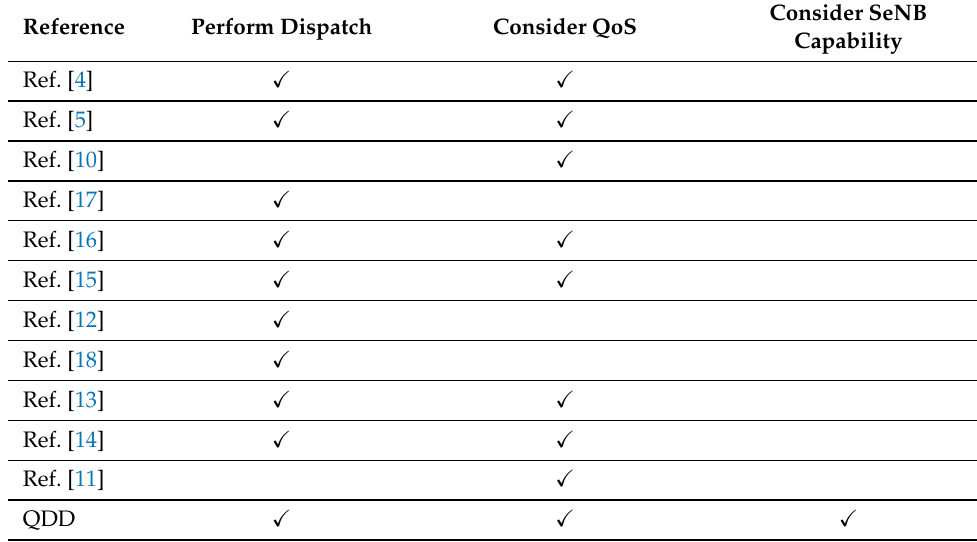
Table 1. Comparison of prior works with